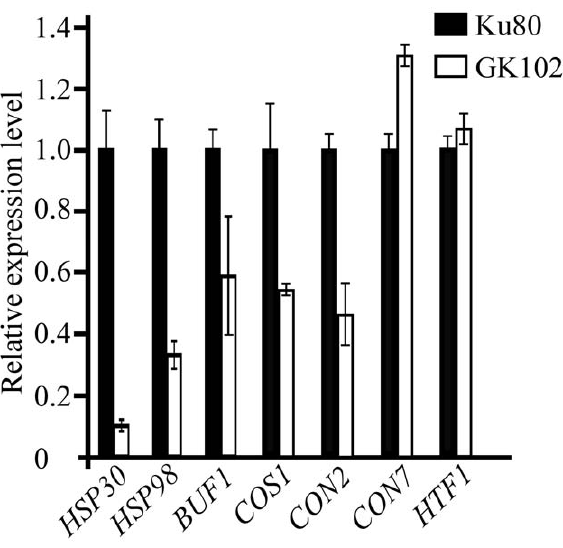
Figure 7. qRT-PCR assay of MoHSP30 , MoHSP98 , BUF1 , COS1 , CON2 , CON7 , and HTF1 expression in the Ku80 and Mosfl1 mutant strains. The relative expression levels of MoHSP30 , MoHSP98 , BUF1 , COS1 , CON2 , CON7 , and HTF1 were compared between the GK102 and Ku80 strains (arbitrarily set to 1) cultured at 30 u C. Mean and standard error were calculated with data from three biological replicates.